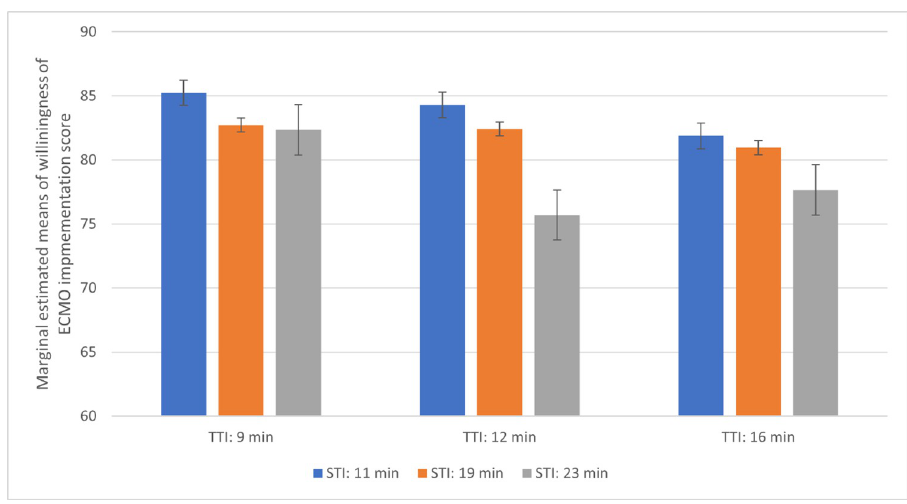
Fig 2. Analysis of estimated marginal means test and post hoc Bonferroni-adjusted pairwise comparison for prehospital time factors across vignettes. STI: Scene time interval; TTI: Transportation time interval; p -values from the post hoc Bonferroni adjusted pairwise